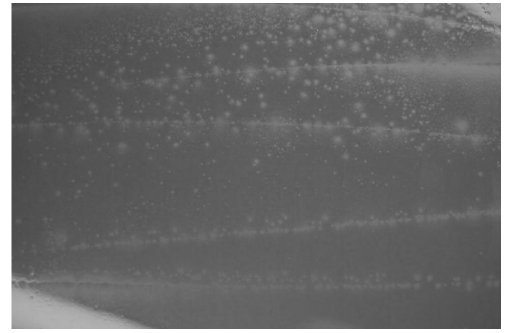
Fig. 1. Halozone around colony of bile salt hydrolase Fig. 2. Agarose gel electrophoresis of PCR product from bsh gene amplification. Lane 1: 100 bp DNA ladder RTU and Lane 2: PCR product of bsh gene amplification from L. plantarum